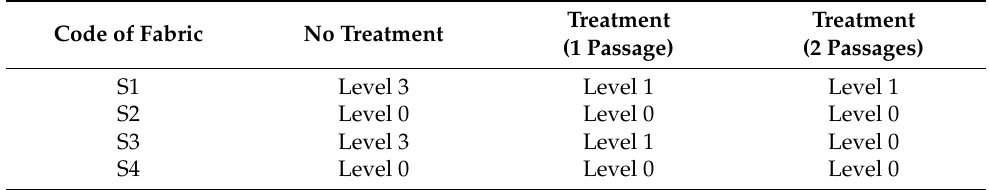
Table 2. Level of aqueous liquid repellence test for the untreated and treated fabrics with corona, after one and two